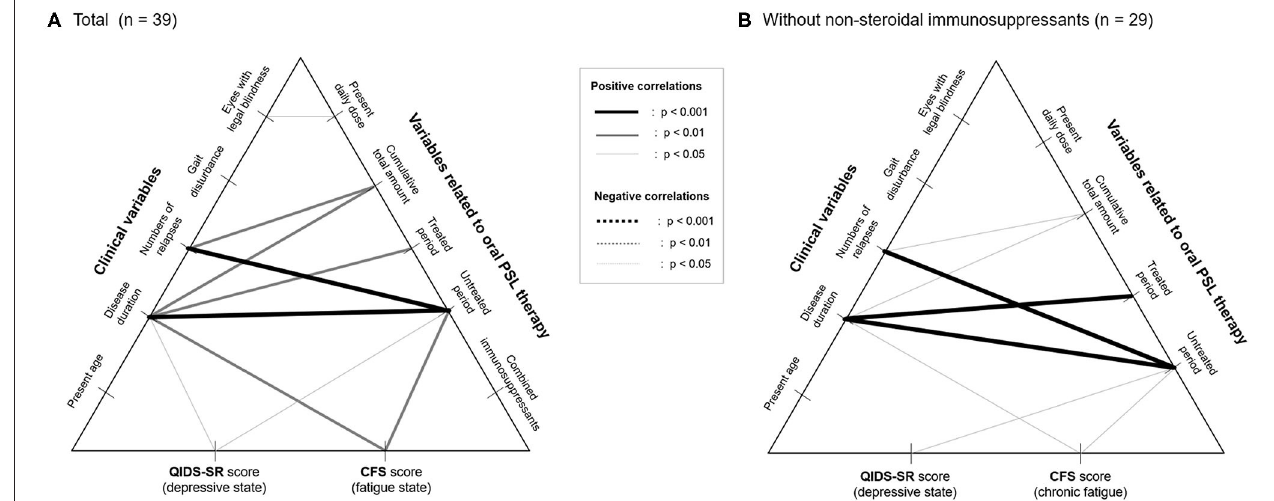
FIGURE 3 | Correlation networks between clinical data, therapeutic variables, and insidious symptoms. Correlation networks in the total patients (A) and in those without the use of non-steroidal immunosuppressants as a potential confounder (B) are shown. None of the therapeutic variables, except for the duration of the untreated period with relapse prevention therapies, show a significant correlation with the evaluated insidious symptoms irrespective of the usage of nonsteroidal immunosuppressants. CFS, Chalder Fatigue Scale; PSL, prednisolone; QIDS-SR, self-reported Quick Inventory of Depressive